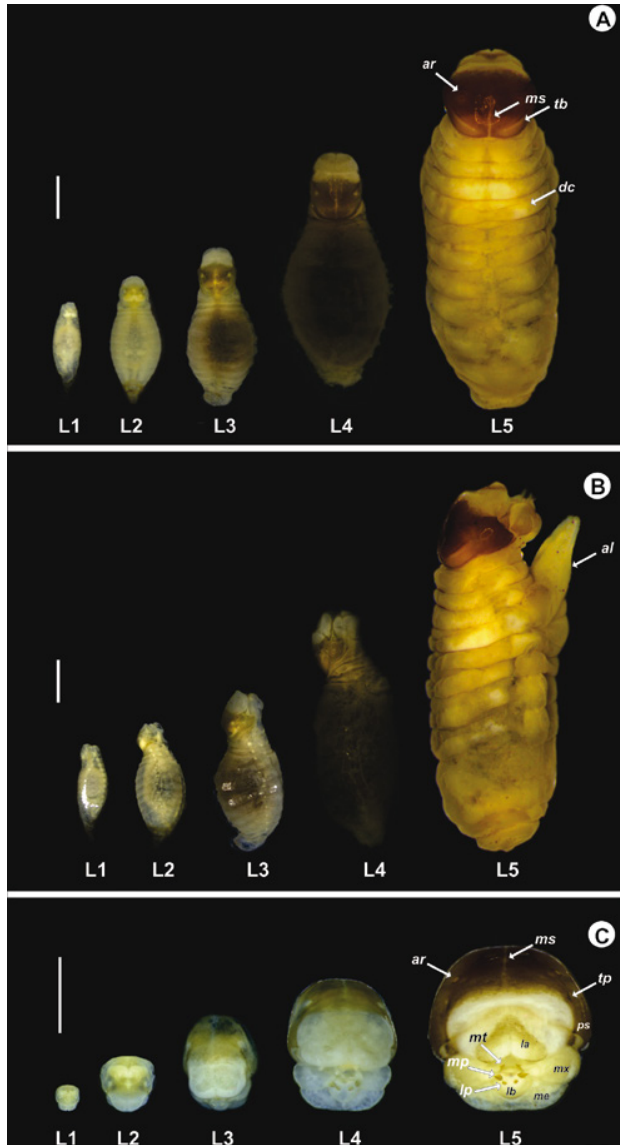
Fig 2. Dorsal (A), lateral (B) views of larvae and frontal view of cephalic capsules (C) of Mischocyttarus nomurae (Hymenoptera, Vespidae): (L1 – L5) – 1 st to 5 th instar larvae, respectively. al